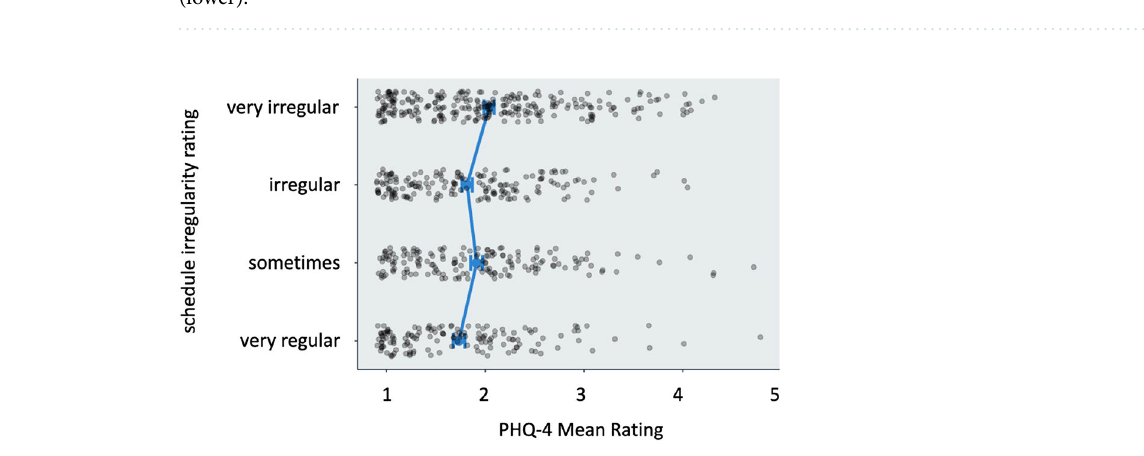
Figure 3. Slide plots for perceptions of sleep amount (left) and tiredness (right) split by schedule regularity (lower).